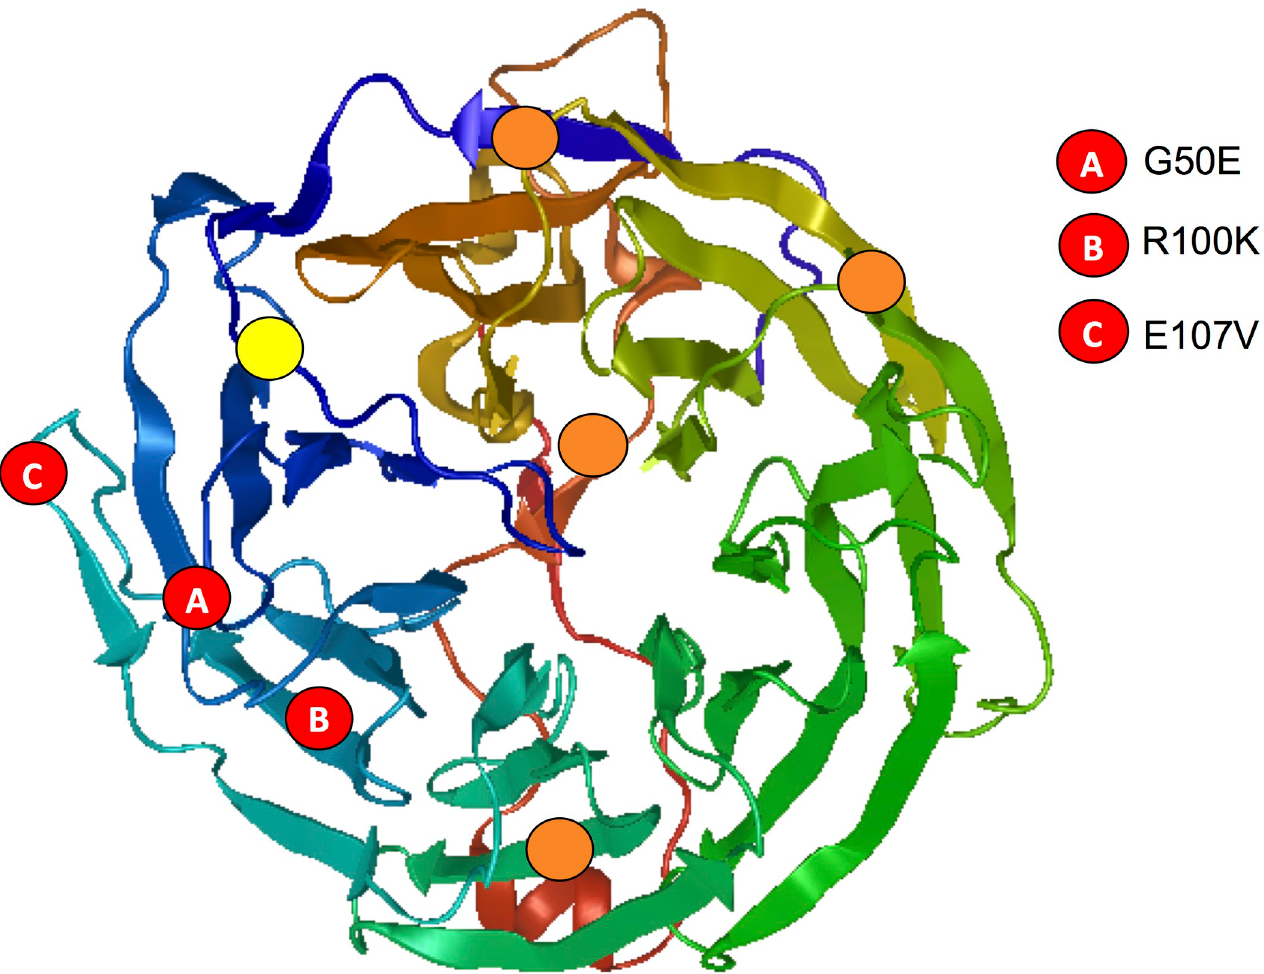
Fig 5. Mutations in Pf Coronin conferring resistance to artemisinin are at opposite ends of the putative actin binding sites. Structure of WD-40 domain of Plasmodium falciparum generated through SWISS-MODEL homology modeling [22] using the crystal structure of the WD-40 domain of Toxoplasma gondii Coronin ( 4OZU.pdb) [24], which is 43% identical with 99% coverage to the the WD-40 domain of P . falciparum . The predicted actin binding sites are indicated in orange and conserved actin binding site from mouse coronin 1A (R23) [24] indicated in yellow. The mutations that confer artemisinin resistance [17] are indicated in